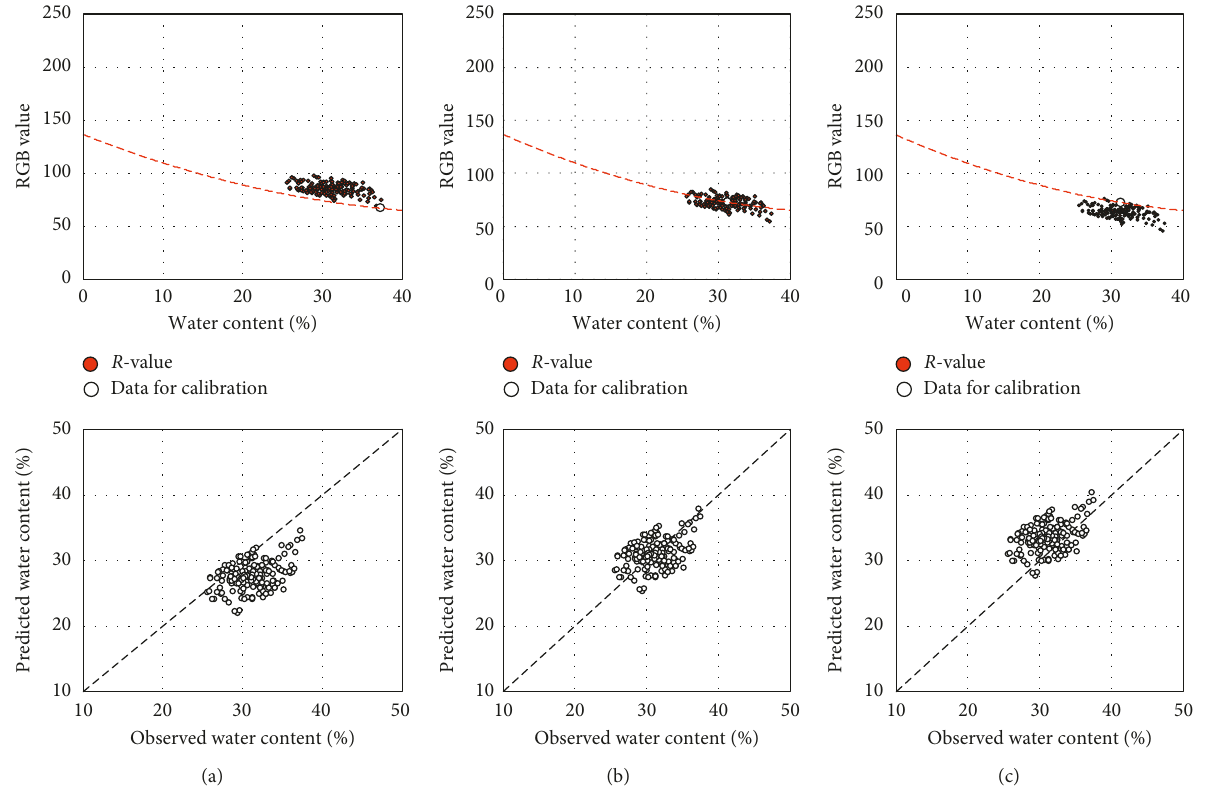
Figure 8: Accuracy change of the estimation result according to correction data selection: (a) case 1; (b) case 2; (c) case 3.